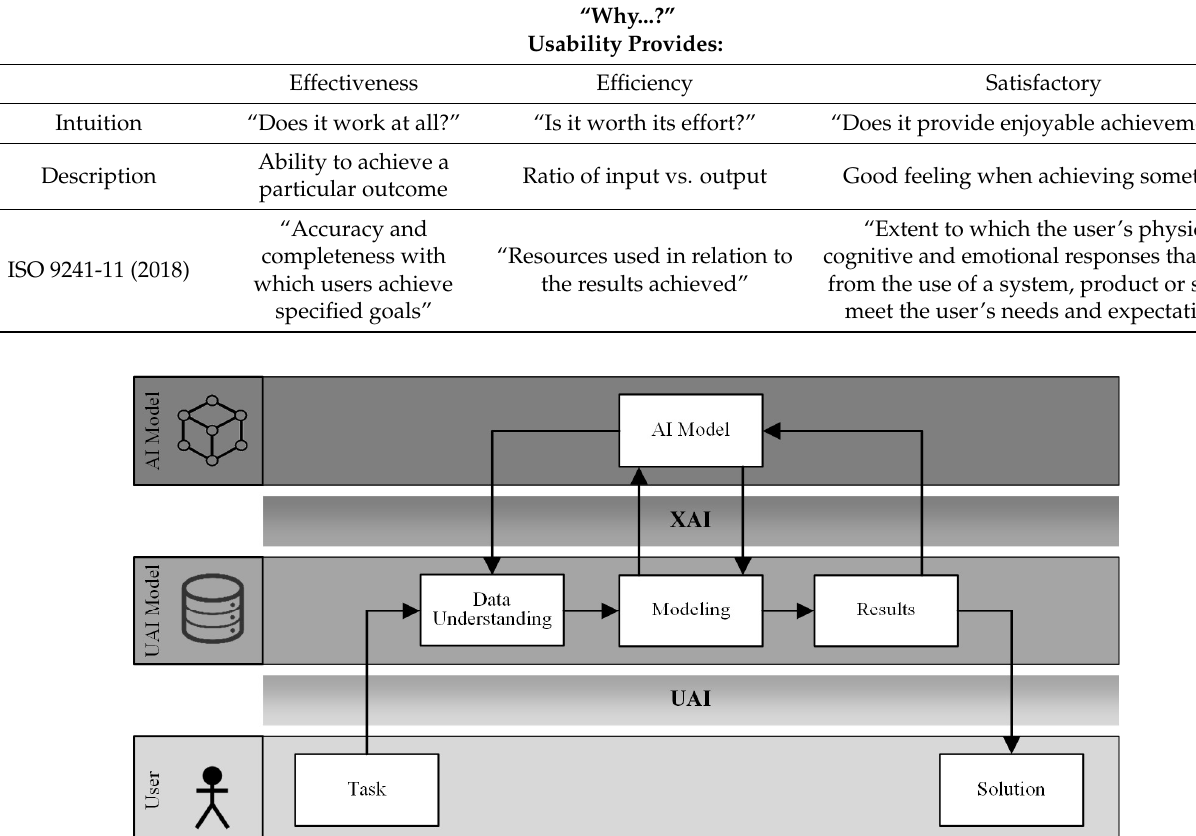
Figure 3. Layers of AI model comprehensiveness. Table 2. Definition of usability characteristics.